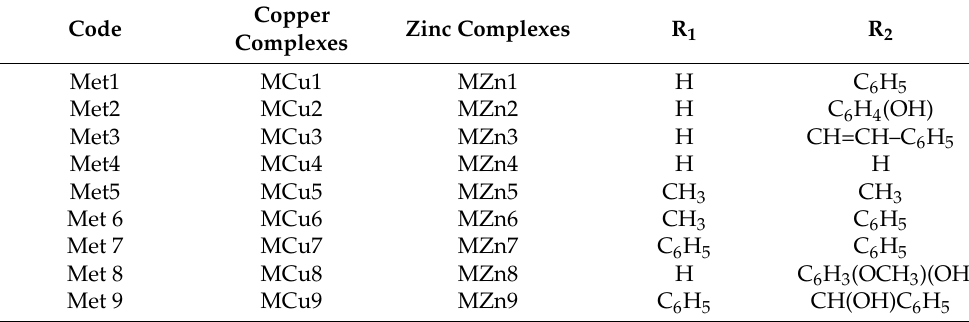
Table 12. Copper and Zinc metal complexes with functional